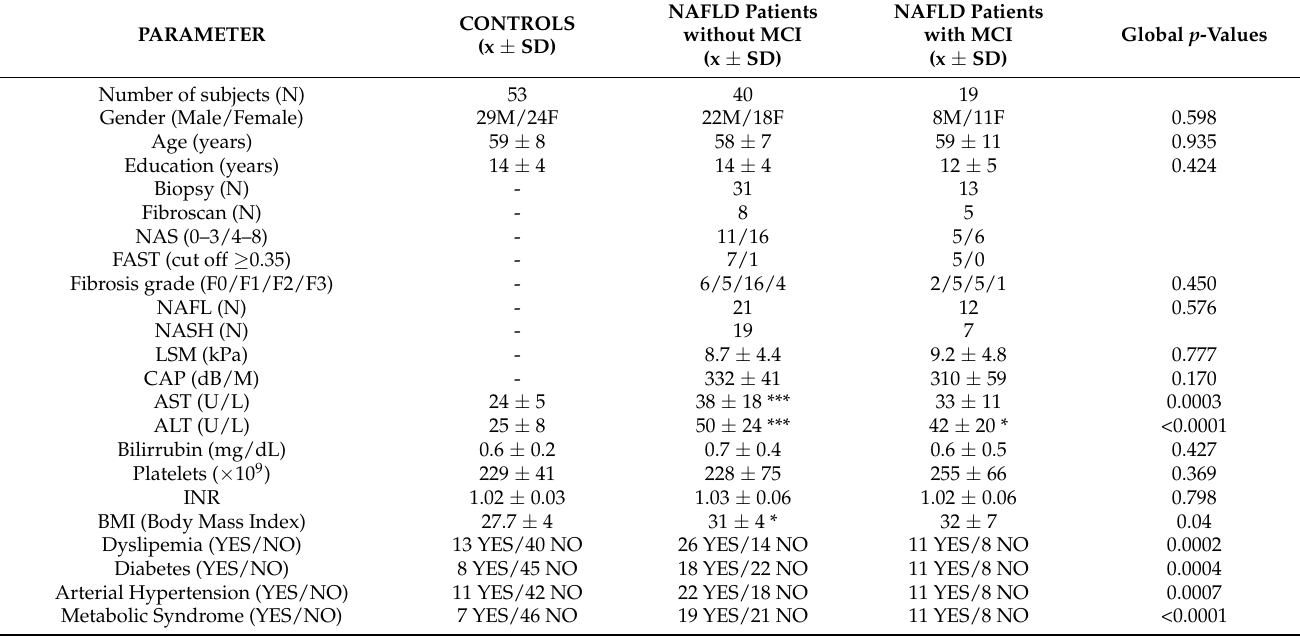
Table 1. Patients